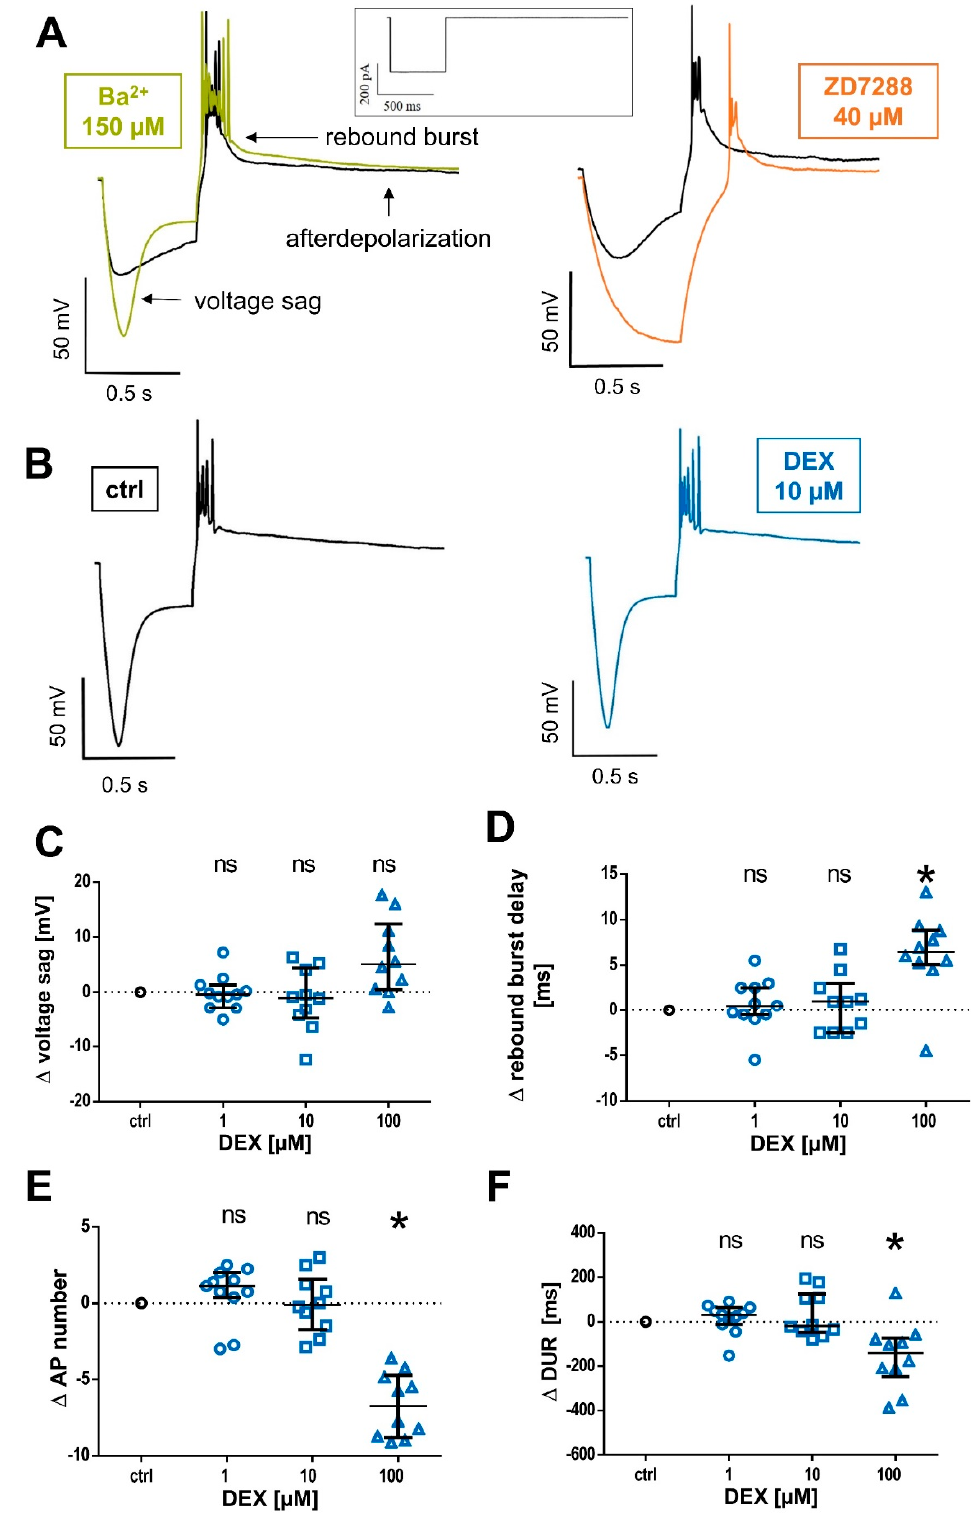
Figure 4. ( A ) TC replay neurons display an inwardly directed rectification of the membrane potential upon hyperpolarizing current injection ( − 350 pA, 500 ms, and the current protocol is shown on top), termed voltage sag. The voltage sag is unmasked in the presence of Ba 2+ (green, 150 µM), on the left panel. Low-threshold calcium spike rebound burst-firing (rebound burst) is followed by an HCN channel-mediated afterdepolarization. In comparison, there is no quantifiable voltage sag in the presence of HCN channel blocker ZD7288 (orange, 40 µM), corresponding to a complete sup- pression. ( B ) Exemplar current-clamp recordings in the absence and after 45 min of 10 µM DEX